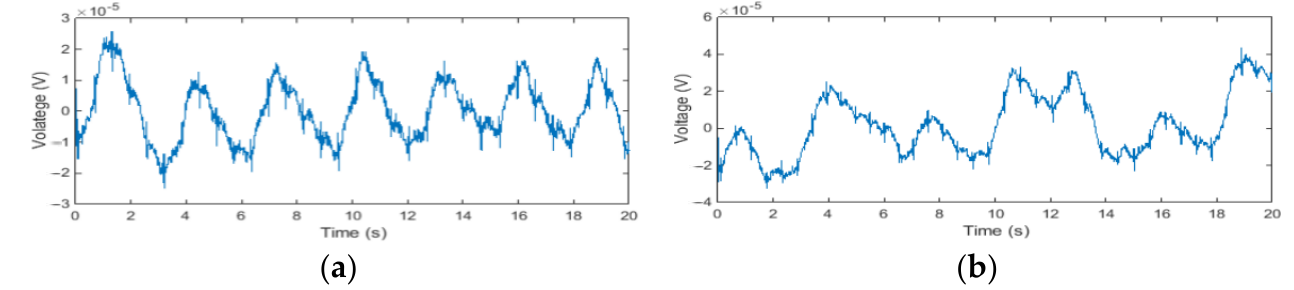
Figure 5. The IP signal recorded by the ECG -IP acquisition system: ( a ) the IP signal contains car- diac-related artifacts; ( b ) the IP signal contains cardiac-related artifacts and motion artifacts.